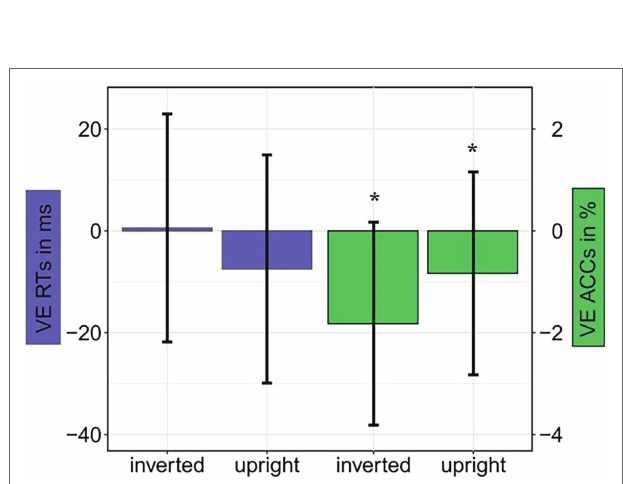
FIGURE 8 | Experiment 2: Mean validity effect (VE) in reaction times (RTs; invalid minus valid; blue bars) and accuracies (ACCs; valid minus invalid; green bars) depending on Orientation (upright; inverted). Error bars represent 95% confidence